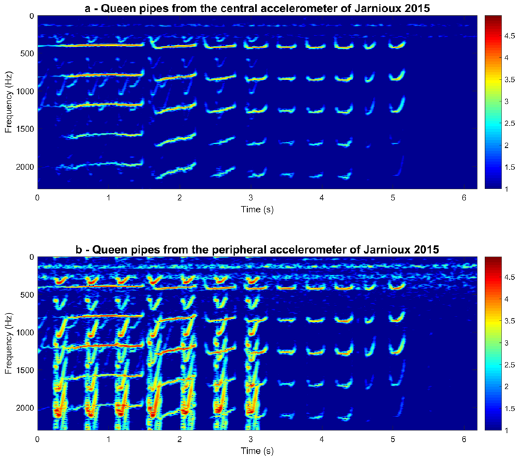
Figure 9. Spectrogram of raw spectra containing the toots and quacks found in the section highlighted in Fig. 8. Data shown are for the accelerometers situated at the centre (Top, a ) and at the periphery (Bottom, b ) of the frame. Colour coding represents logarithmic spectral amplitude from low (blue) to high (red) in arbitrary units. This figure was created using the MATLAB (R2018b) software (uk.mathworks.com).